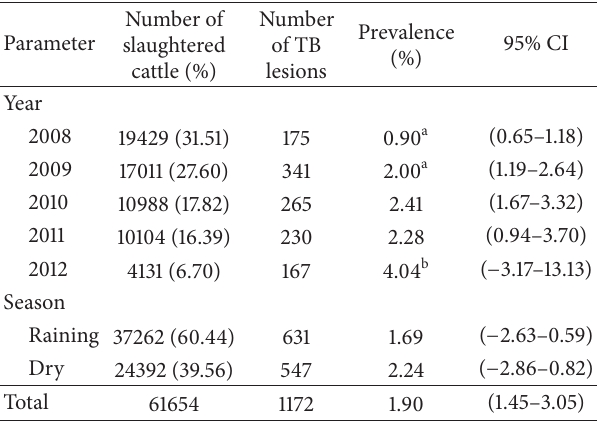
Table 1: Annual prevalence of tuberculosis lesions in cattle slaugh- tered in Makurdi abattoirs from 2008 to 2012.